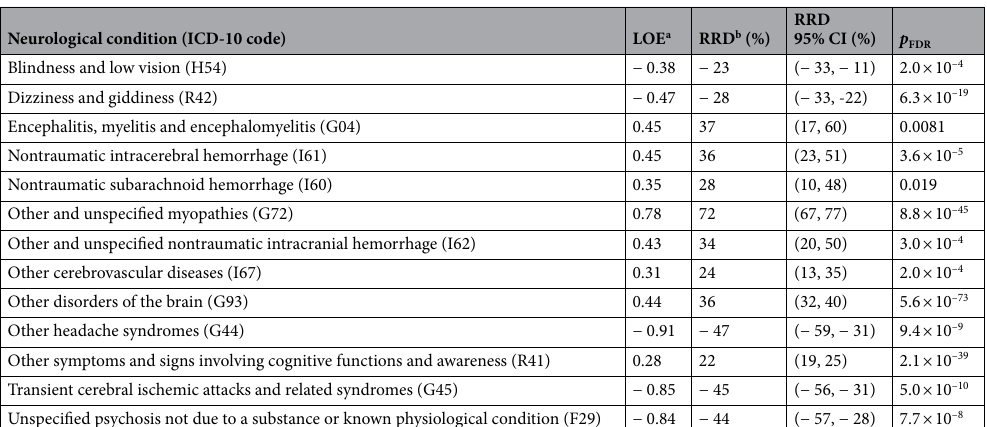
Table 1. Statistically significant associations of neurological conditions and severe disease status after admission ( p FDR < 0.05). a The interactive data table (https:// covid clini cal. github. io/ Phase1. 1Neur oRCode/ 01- analy sis- icd10. html# enric hment_ tab) and the results directory of the project online data repository (https:// github. com/ covid clini cal/ Phase1. 1Neur oRCode/ tree/ master/ resul ts) show the log 2 value of enrichment (LOE), 95% confidence intervals, and p values for all neurological ICD-codes adjusted for multiple hypothesis testing. b RRD: Relative risk difference = Observed relative risk −